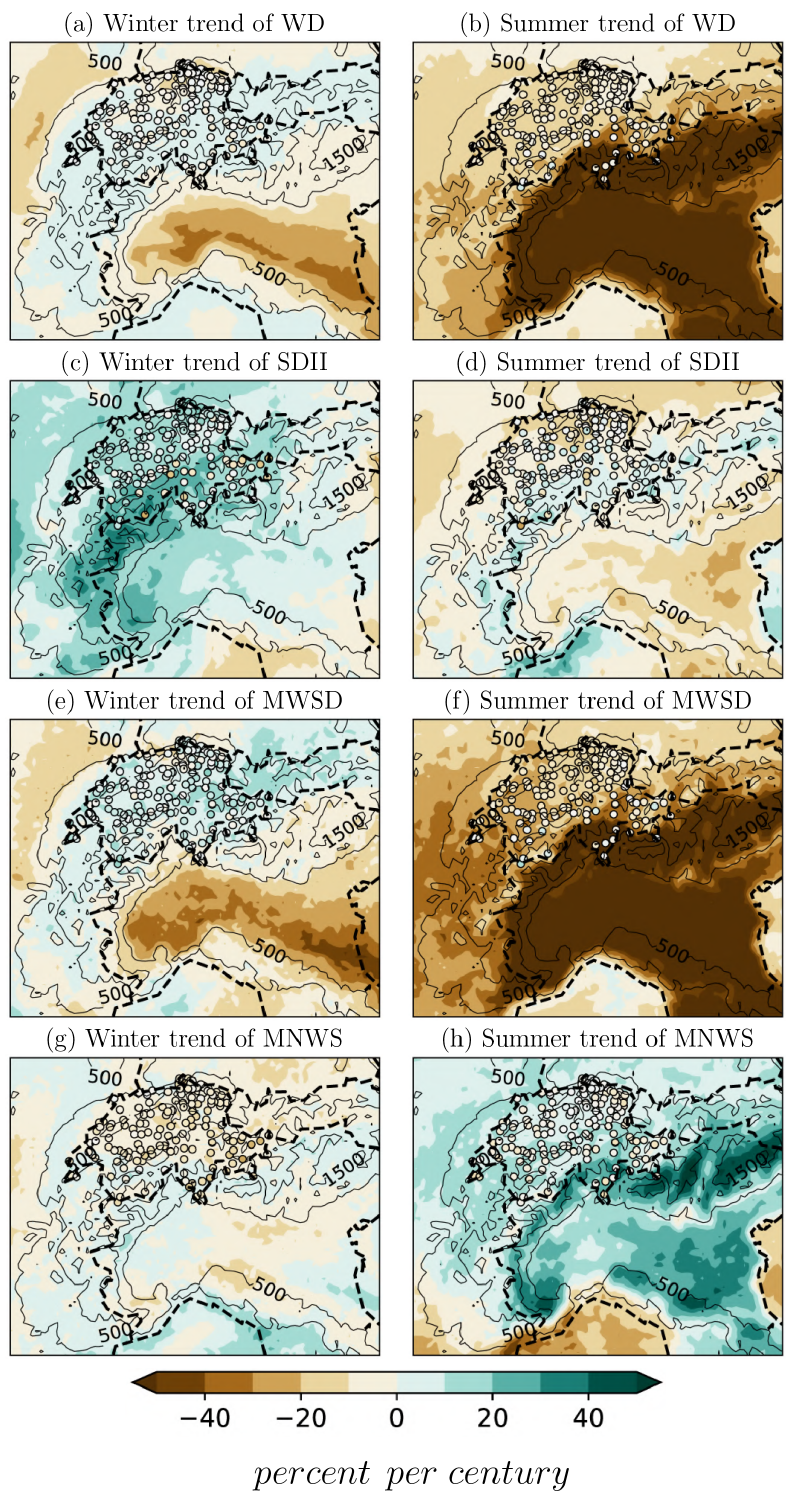
Figure 6. Winter and Summer 1903–2010 trends (% per century) of WD (a, b) , SDII (c, d) , MWSD (e, f) and MNWS (g, h) simulated by MAR (shaded) and locally observed in Switzerland (dots). WD is computed as a percentage of the available daily data for observations. Any station from the observational network that includes missing data is excluded when computing the